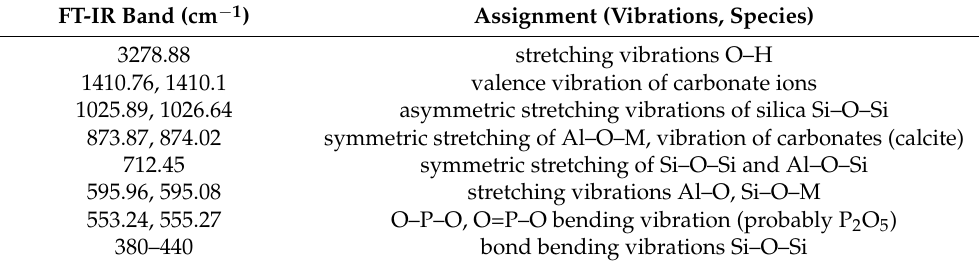
Figure 13. FT-IR spectrum of SS-FA before and after Ni(II) adsorption. Table 6. FT-IR peaks of SS-FA.